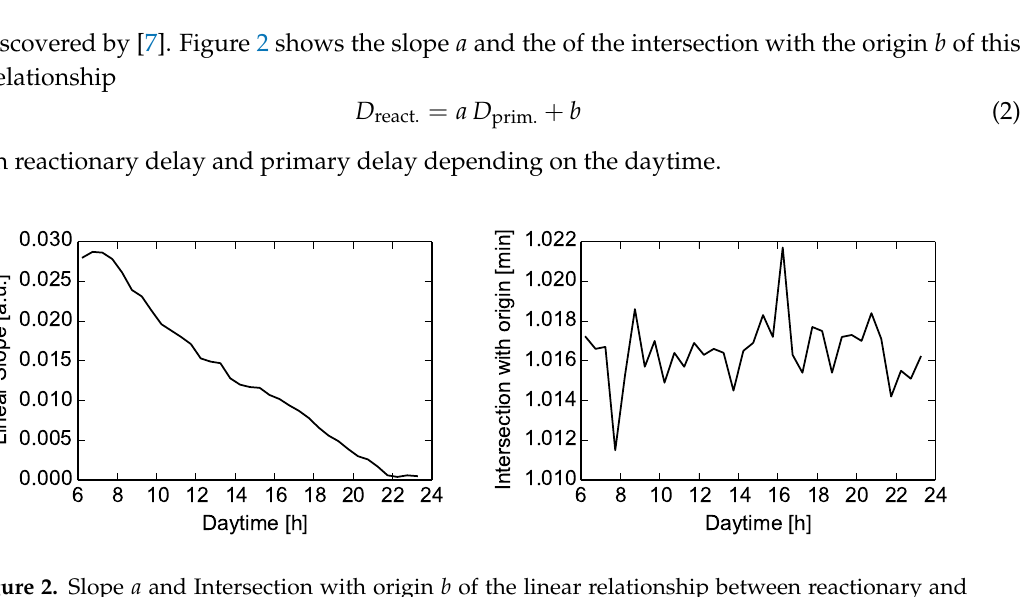
Figure 2. Slope a and Intersection with origin b of the linear relationship between reactionary and primary delay depending on